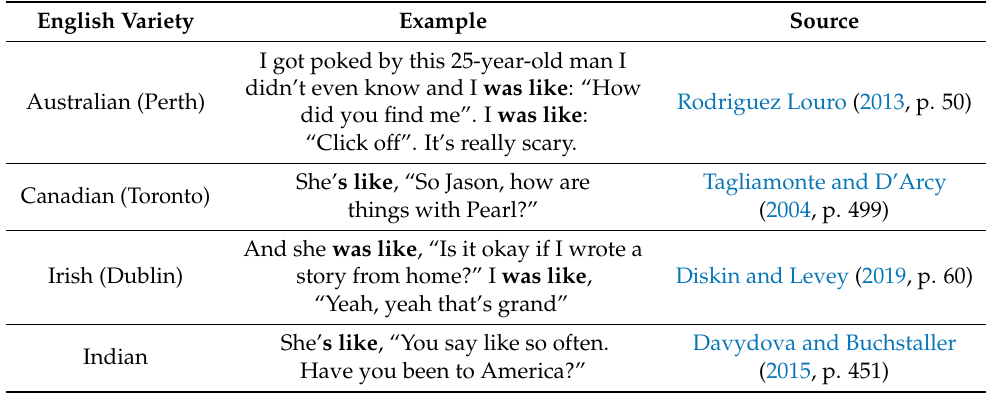
Table 1. Use of quotative be like in different English